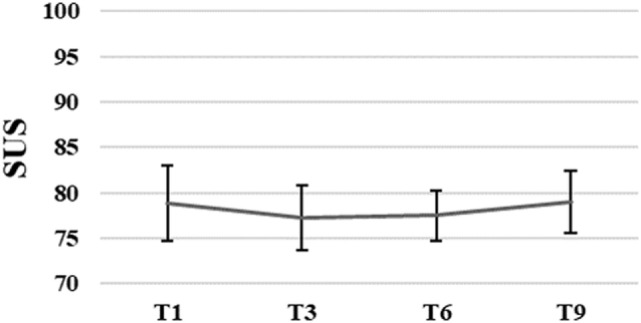
Group means with SEM for the results of the System Usability Scale (SUS) scores measured at different time points.